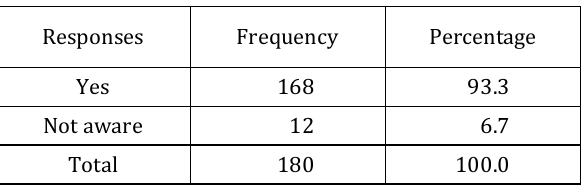
Table 1. Presence of by-laws and regulations for